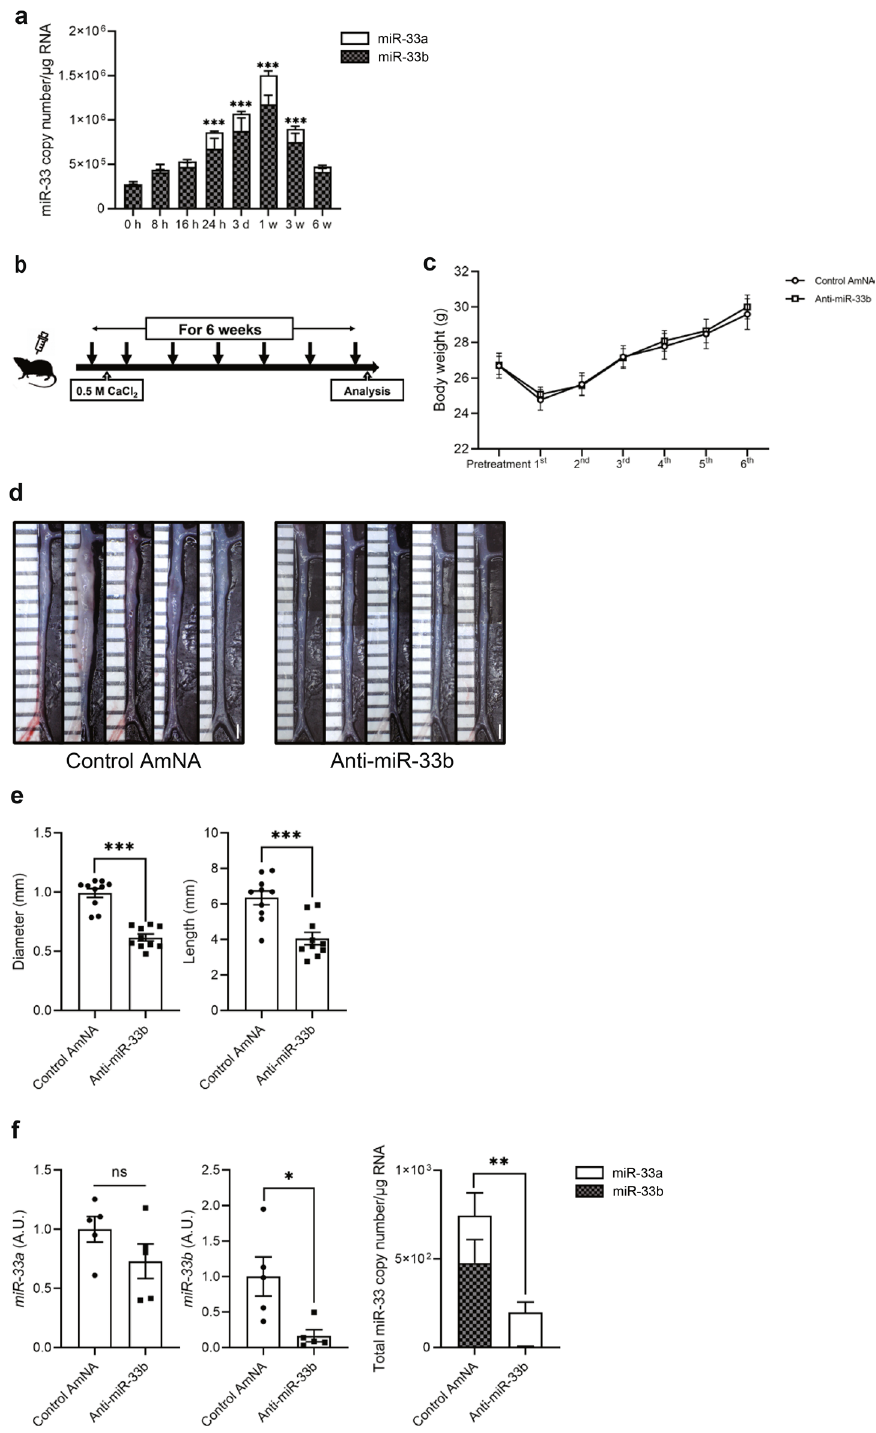
Figure 3. Beneficial effects of AMO administration against miR-33b to miR-33b KI mice for 6 weeks on CaCl 2 -induced AAA formation. ( a ) Copy number changes of miR-33a/b in abdominal aorta over a 6-week period, n = 8 mice in each group. One- way ANOVA with Dunnett’s multiple comparison test. ***P < 0.001 compared with baseline analysis. ( b ) Protocol scheme of administration of AMOs for 6 weeks. ( c ) Serial body weight changes during the experimental period, n = 20 mice with control AmNA administration, n = 19 mice with anti-miR-33a administration, and n = 28 mice with anti-miR-33b administration. ( d ) Representative photographs of CaCl 2 -induced AAA with administration of the indicated AMOs to miR-33b KI mice once a week for 6 weeks. White bars indicate 1 mm. ( e ) Maximum diameter and lesion length of abdominal aorta between left renal artery and terminal aorta of CaCl 2 -induced AAA, n = 10 mice in each group. Mann–Whitney test (left) and unpaired two-tailed t test (right). ***P < 0.001. ( f ) Expression levels of miR-33a (left) and miR-33b (mid), and absolute copy numbers of miR-33a and miR-33b (right) in the CaCl 2 -induced AAA of miR-33b KI mice with administration of the indicated AMOs, n = 5 mice in each group. Unpaired two-tailed t test (left and right) and Mann–Whitney test (mid). *P < 0.05 and **P < 0.01. ns is defined as not significant. All data represent mean ±